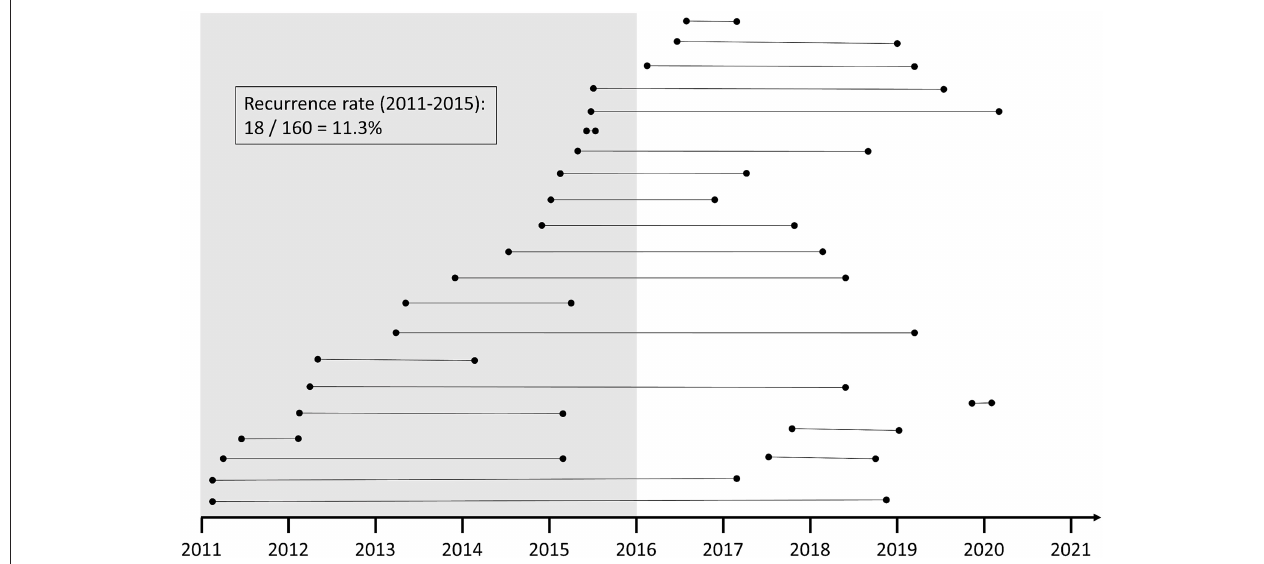
FIGURE 2 | Illustration of the temporal sequence of TGA patients with subsequent recurrence. To assess the recurrence rate, all patients from 2011 to 2015 were chosen as the comparison group to ensure a sufficient duration of the follow-up